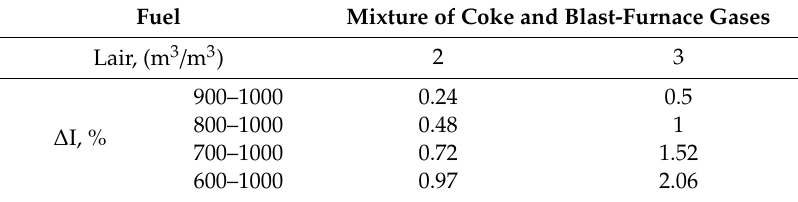
Table 6. Change of the ratio of the fuel amount movement to the total momentum of the reactants at various actual air flow rates.